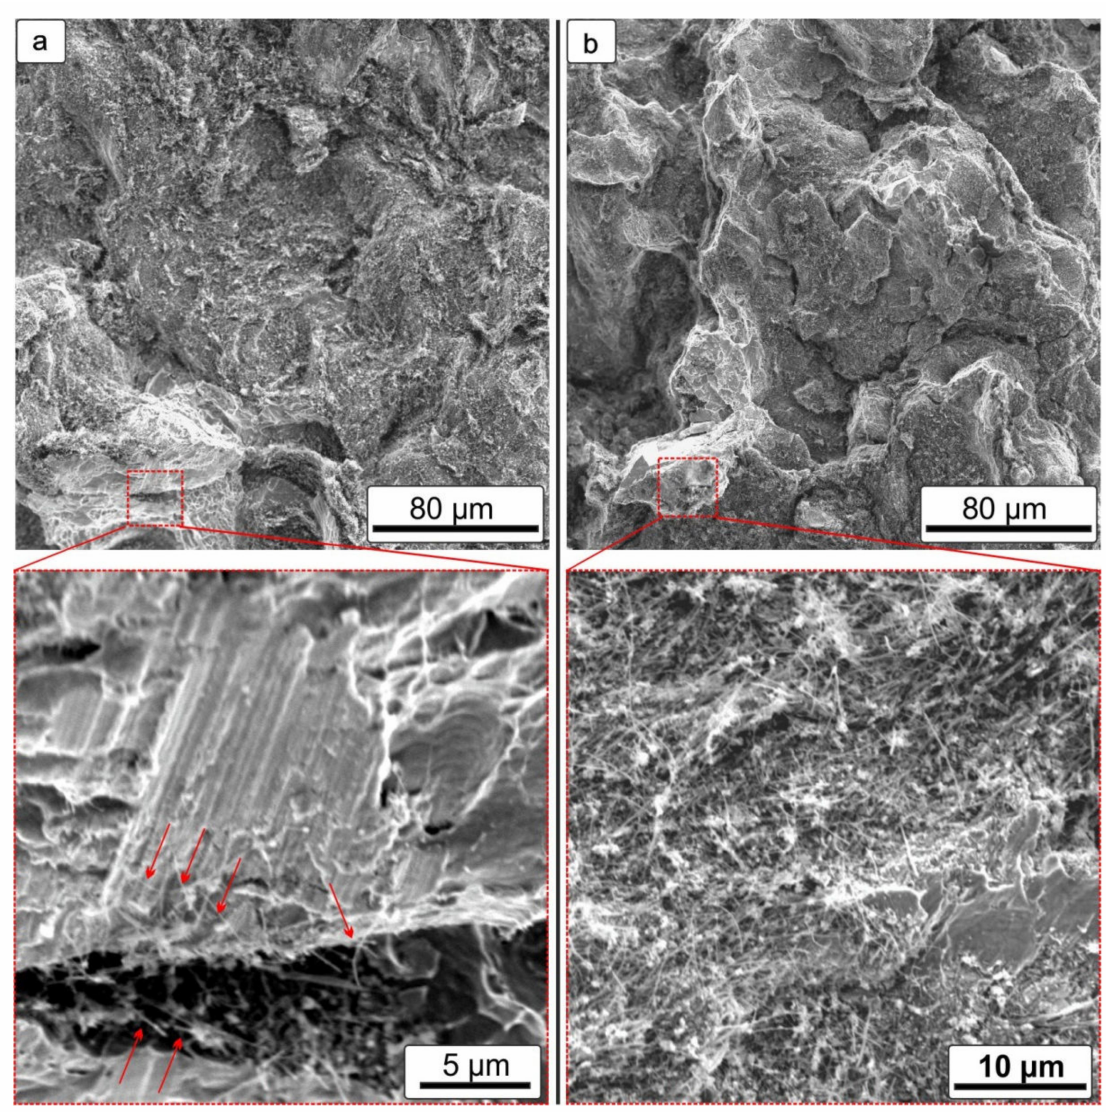
Figure 7. SEM images of fractured surfaces for ( a ) AA024 - 2 wt.% MWCNT and ( b ) AA2024-4 wt.% MWCNTs produced through DPDS